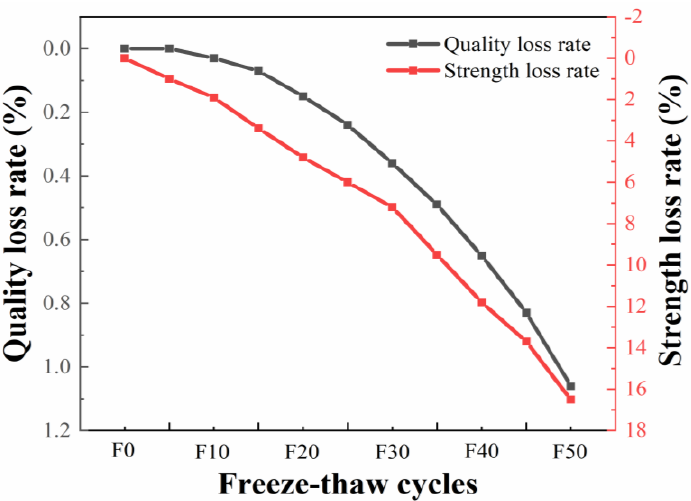
Figure 15. Quality and strength loss of MGB sintered brick under different freeze–thaw cycles.